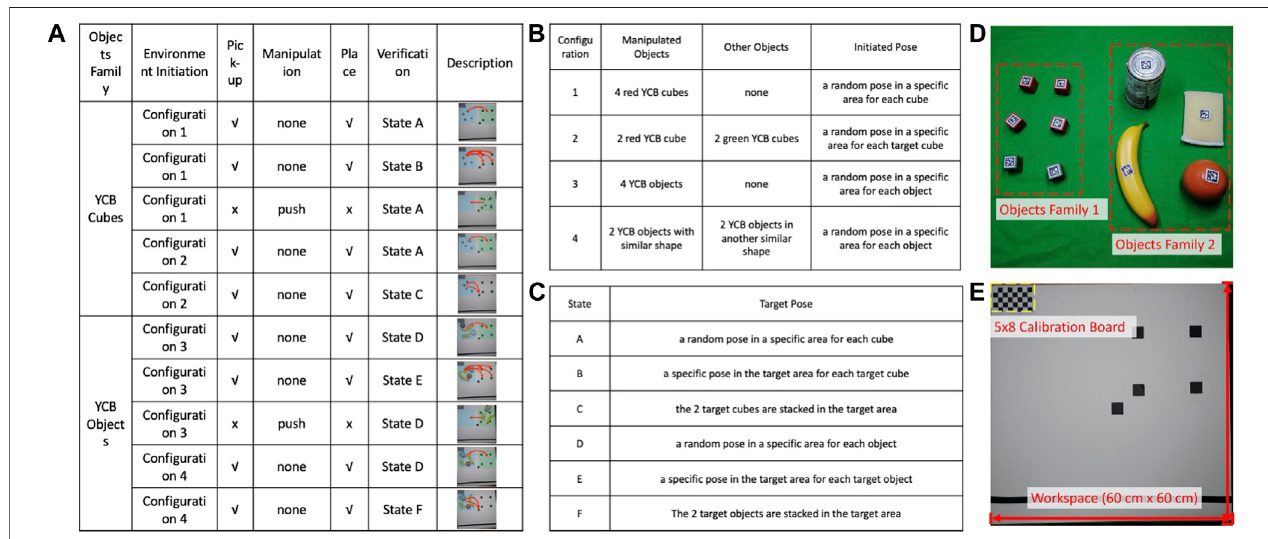
FIGURE 5 | We de fi ned 10 manipulation tasks shown in (A) . This paper uses two objects families: four red and two green wooden cubes as one set and four common objects from YCB as another set. We stress two states and three operations in one manipulation task: initial state, target state, picking, pushing, and placing. The details of different initial states and target states are listed in (B,C) . The two families of objects from YCB are shown in (D) : A set of six cubes; a set of the orange, banana, sponge, and can. The setup of tabletop is shown in (E) .